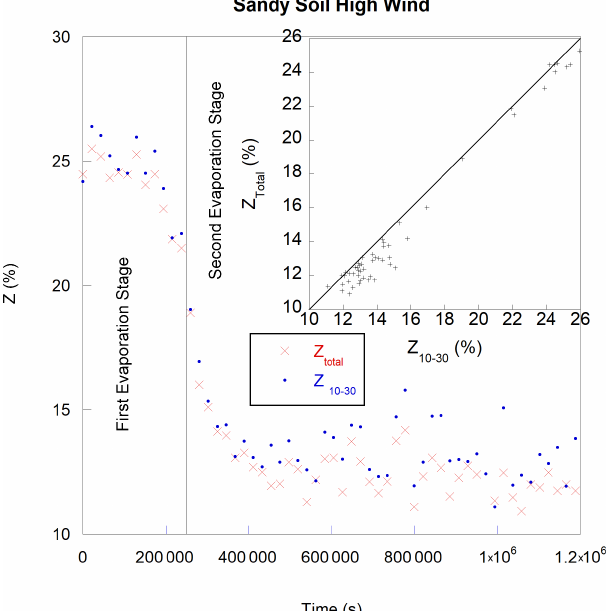
Figure 7. m versus wind speed W S for sandy soil and clayey